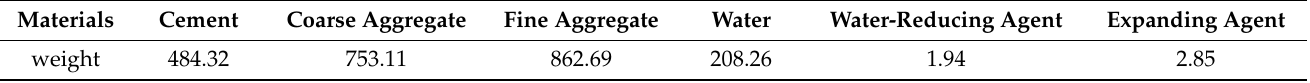
Table 2. The repaired concrete ratio.